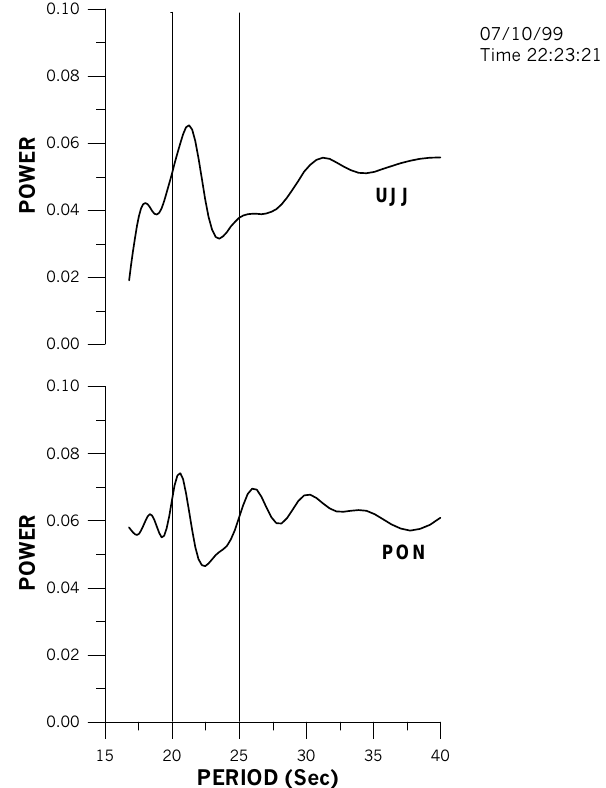
Fig. 4. Power spectrum of the 2 s averaged filtered scintillation on the specified day, at local time and at the specified stations. The plot shows a broader spectral peak around the eigen-period at Pondicherry, but does not show any such peak at Ujjain. The range of the eigen-period has been marked by the interval between two vertical